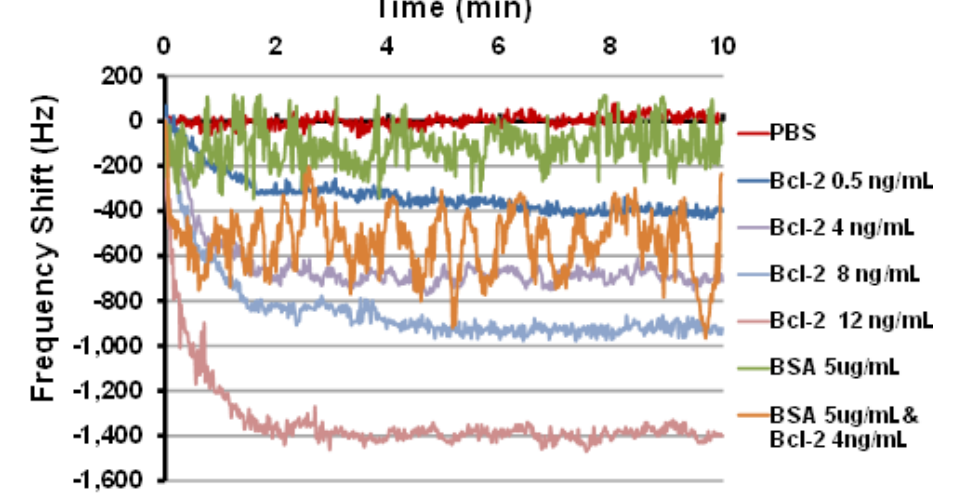
Figure 5. The frequency shifts corresponding to various concentrations of Bcl-2 in PBS, PBS only or BSA controls, and a mixture of Bcl-2 and BSA were measured with a prototype acoustic biosensor.